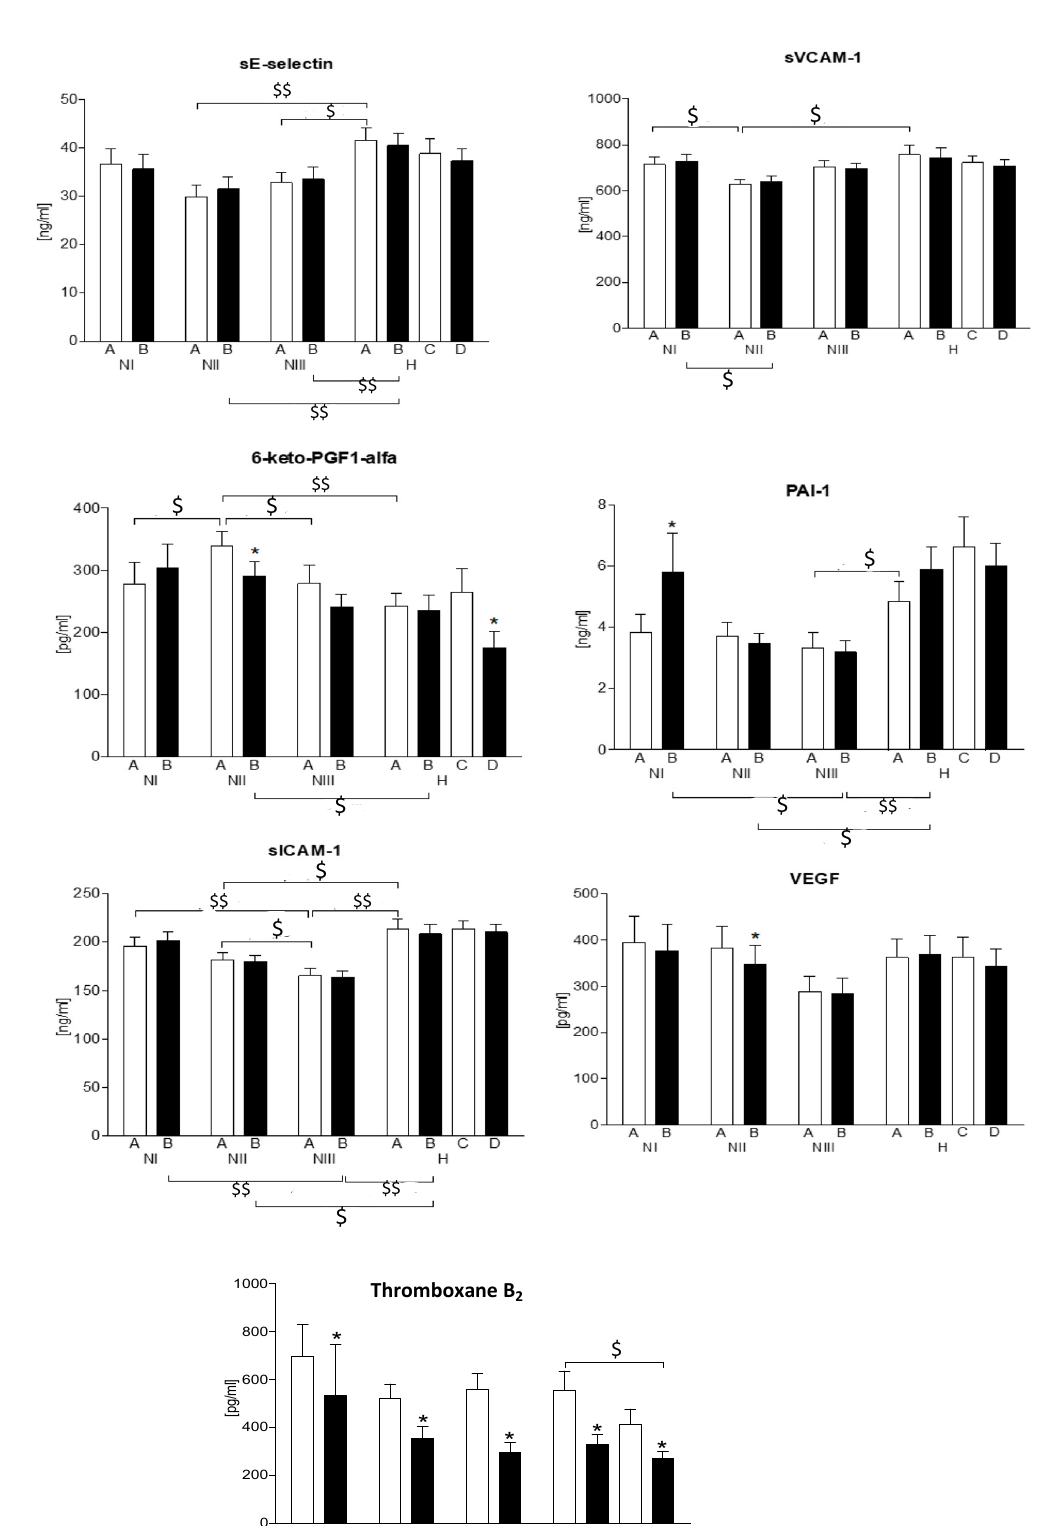
Figure 7. Parameters of inflammatory, angiogenic, and pro-thrombotic endothelial functions. A—baseline; B—after ASA; C—after valsartan; D—after valsartan and ASA. sICAM1—soluble intercellular adhesion molecule-1; sVCAM1—soluble vascular cell adhesion molecule; VEGF—vascular endothelial growth factor; PAI-1—plasminogen activator inhibitor-1. * p < 0.05 A vs. B and C vs. D; $ and $$—p < 0.05 and p < 0.001 vs. another subgroup at the same step of study protocol, respectively.